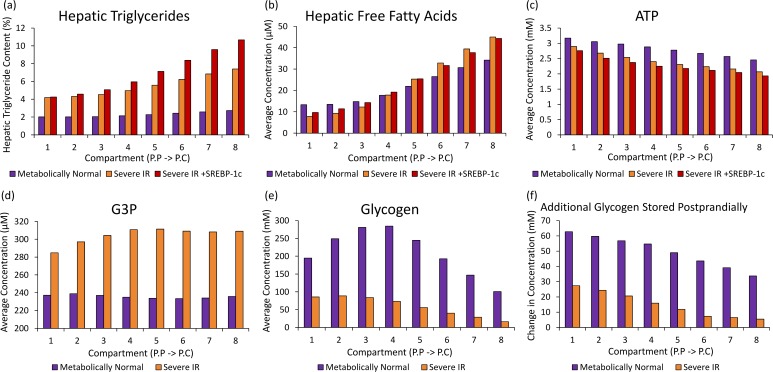
Metabolite concentrations when simulating NAFLD.(a) The average triglyceride (b) FFA, (c) ATP, (d) glycerol-3-phosphate and (e) glycogen concentration and (f) the difference between postprandial peak and pre-prandial trough glycogen concentrations in the different regions of the sinusoid when simulating (purple) a MH individual, (orange) IR alone and (red) IR with increase SREBP-1c expression using a moderate intake diet.